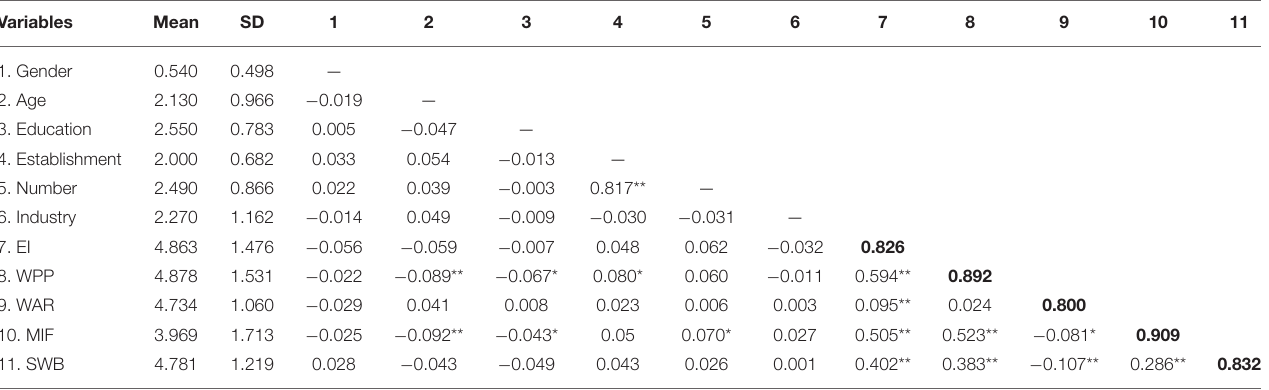
TABLE 3 | Mean, Standard deviations, and correlations for all variables ( N = 882). Variables